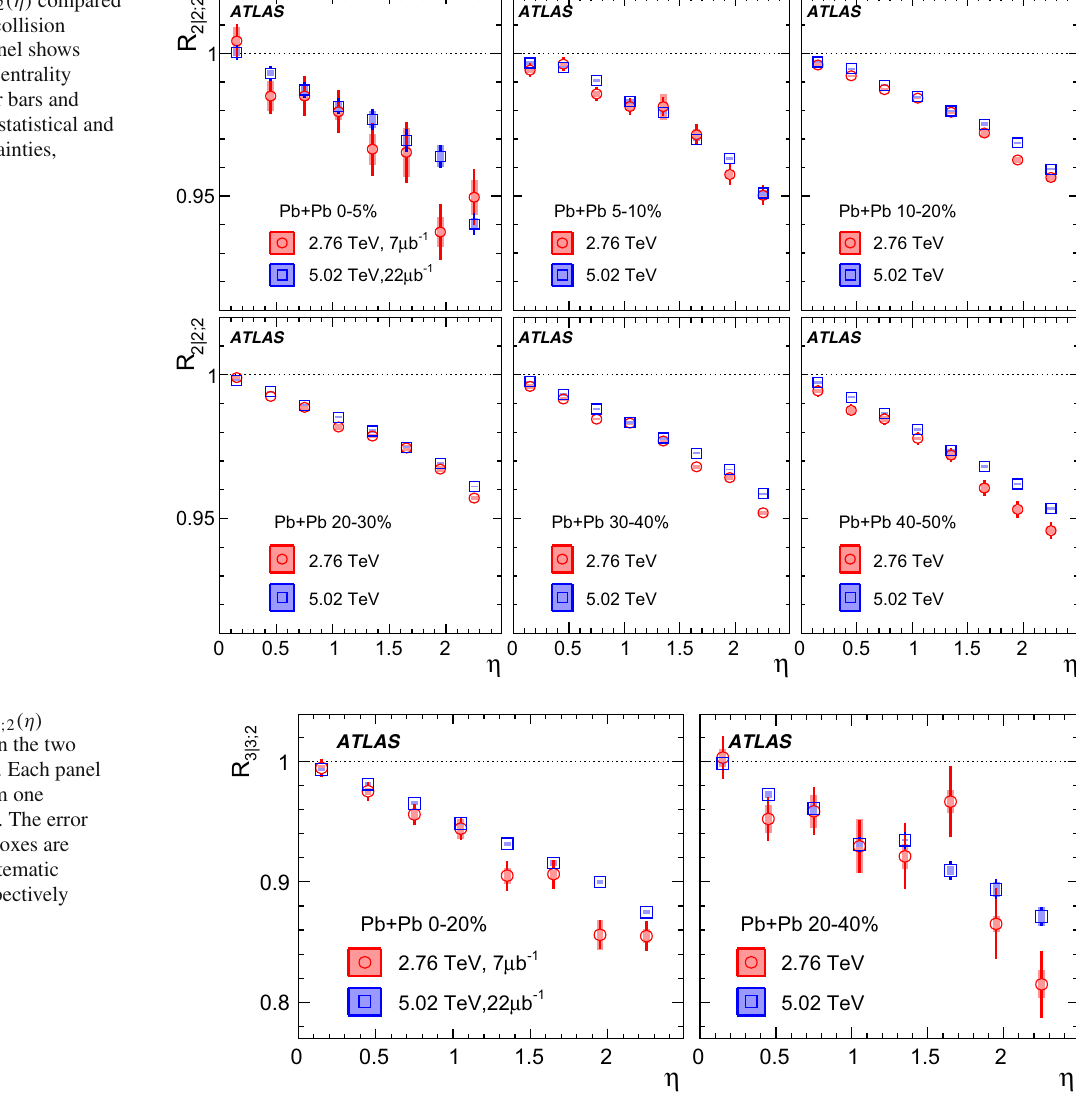
Fig. 9 The R 2 | 2 ; 2 (η) compared between the two collision energies. Each panel shows results from one centrality interval. The error bars and shaded boxes are statistical and systematic uncertainties, respectively